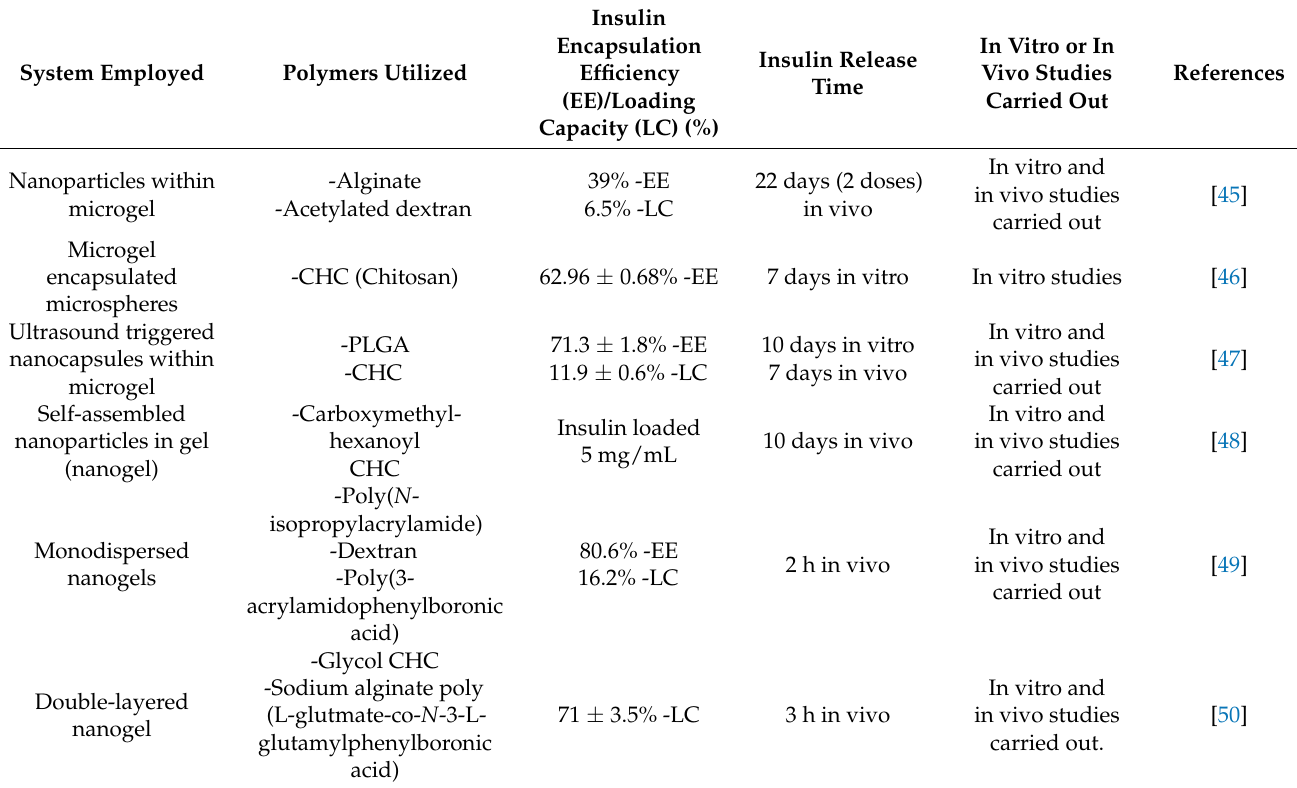
Table 2. Micro- and nano-hydrogel systems for insulin delivery. Including polymers utilized, sustained release time, and whether they have been tested in cell or animal